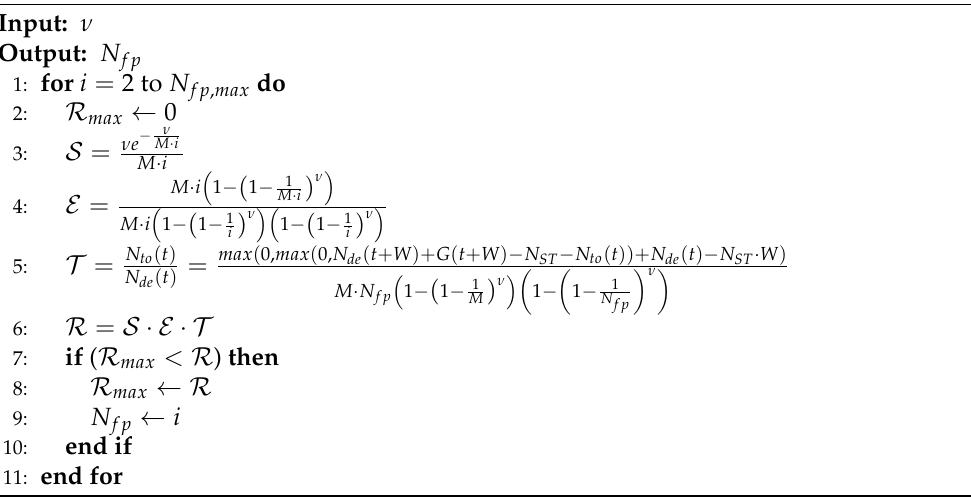
Algorithm 1 Preamble codeword set selection in the base